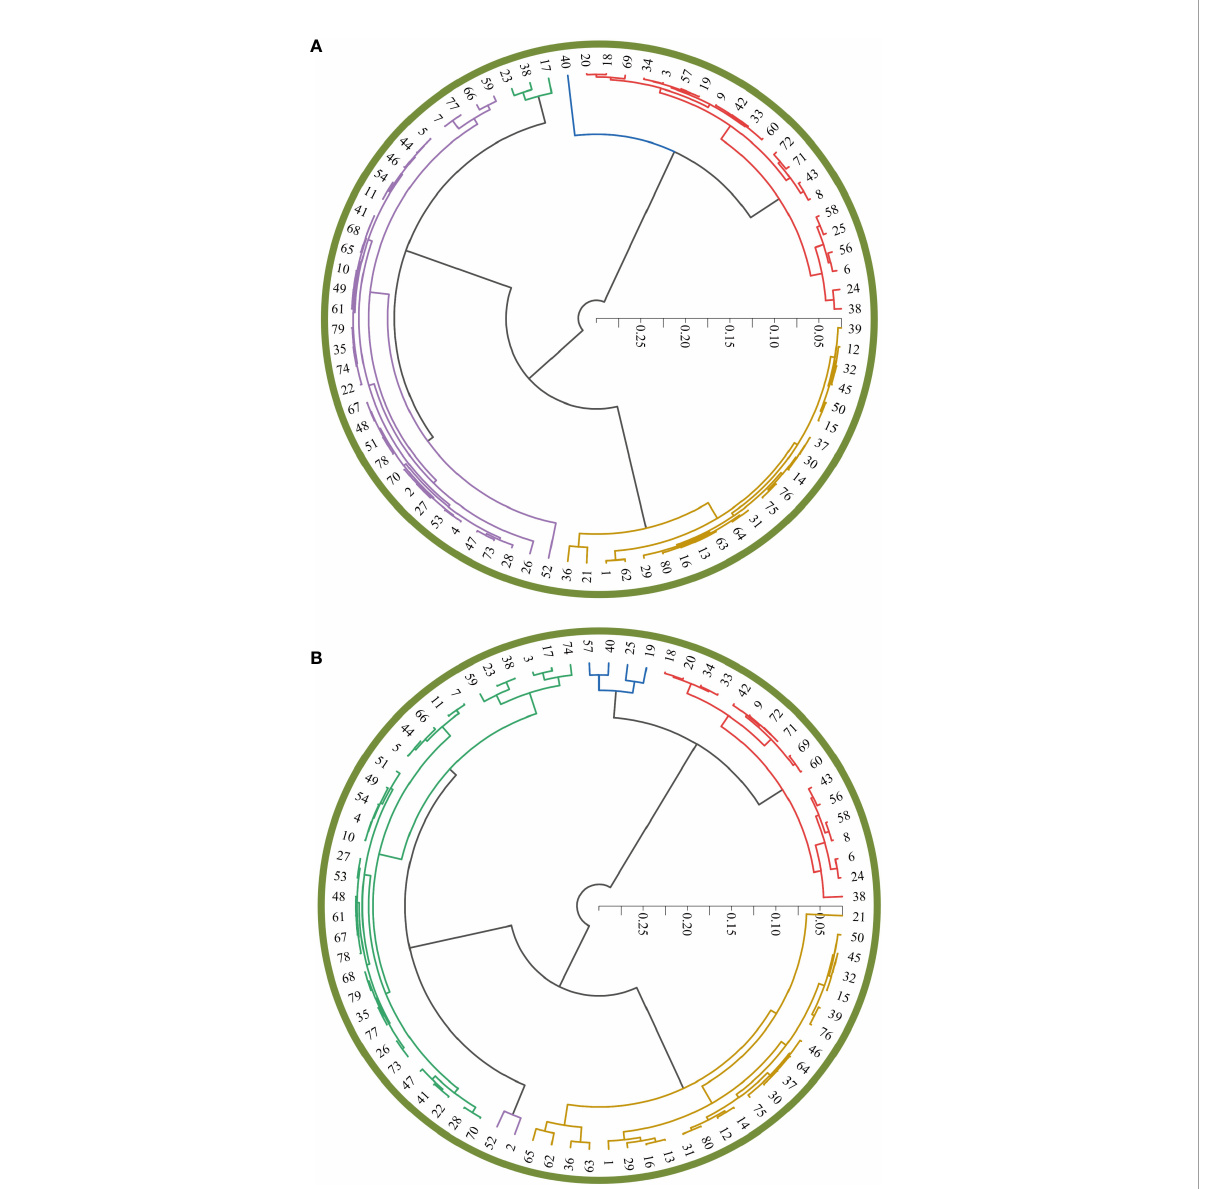
FIGURE 9 Cluster analysis of the drought tolerance coef fi cients of the F v /F m measured values (A) and predicted values (B) for the 80 cotton varieties. 1, Jifeng 554; 2, Jifeng 103; 3, Jifeng 522; 4, Jifeng 908; 5, Jifeng 914; 6, Jifeng 1982; 7, Jifeng 4; 8, 7886; 9, Cangmian 268; 10, Jimian 315; 11, Han 218; 12, Hannong 12; 13, Han 8266; 14, Han 258; 15, Han 686; 16, YM111; 17, Nongda KZ05; 18, Nongdamian 10; 19, Nongdamian 12; 20, Lumianyan 28; 21, Xuzhou 1818; 22, Zhongmiansuo 41; 23, Shandongxiamian11-42; 24, Zhongmiansuo 12; 25, Yumian 19; 26, Ejing 1; 27, Zhongmiansuo 35; 28, Zhongmiansuo 60; 29, Xinshi 71143; 30, Xinza 15; 31, Xinshi 17; 32, GK39; 33, 0 shi; 34, Zhongmiansuo 94A915; 35, Lumianyan 36; 36, DP33B; 37, Guoxinmian01; 38, Guoxinmian02; 39, Guoxinmian03; 40, Guoxinmian05; 41, Hanwu 216; 42, Zhongmian 100; 43, Zhongmiansuo 79; 44, Cangmian 666; 45, Han 6203; 46, Shikang 126; 47, Cang 198; 48, Ji 228; 49, Guoxinmian 9; 50, K836; 51, Lumian 522; 52, Lumian 5172; 53, K638; 54, Guoxin 4; 55, Jifeng1187; 56, Jifeng 1458; 57, Jifeng 103; 58, Jifeng 914; 59, Jifeng 965; 60, MH335223; 61, Guoxinmian 11; 62, Zhongmiansuo 17; 63, Chunbeibao; 64, Zhongmiansuo 60;65, CG3020-3; 66, Jimian 2016; 67, Ji 1518; 68, Jihang 8; 69, Jimian 262; 70, Ji 178; 71, Ji 172; 72, Yuzaomian 9110; 73, Dexiamian 1; 74, Jicai 6913; 75, Zhongmiansuo 23; 76, Zhongmiansuo 50; 77, Ji668; 78, Zhibao 86-1; 79, Jimian 958; 80, Jifeng